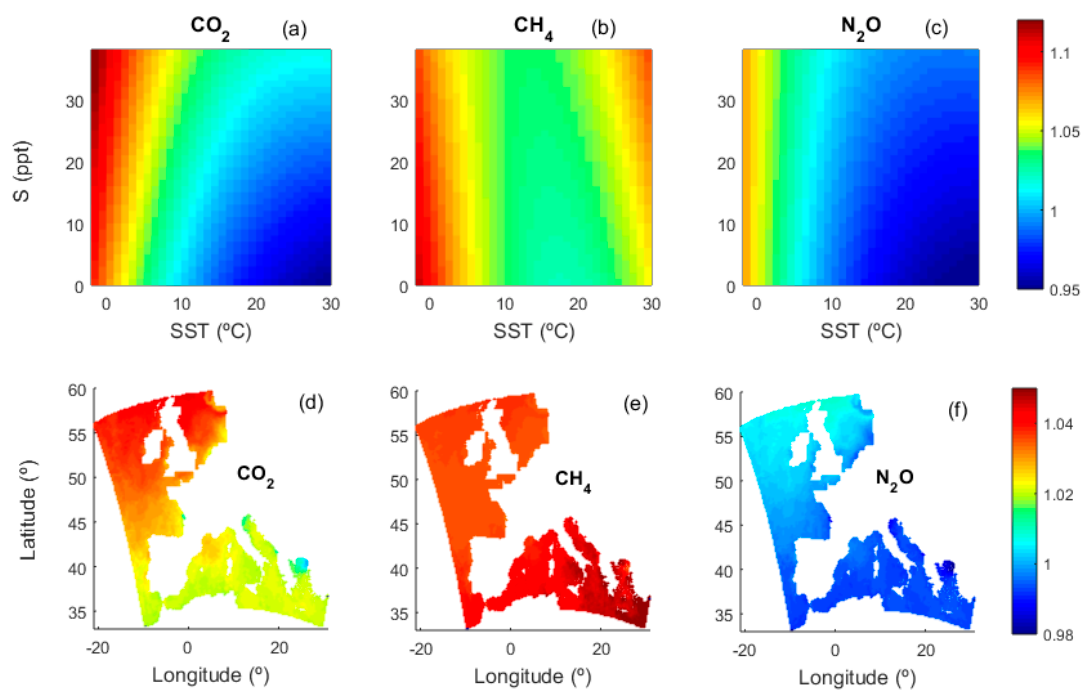
Figure 1. Match–mismatch between estimated solubilities of greenhouse gases. Colour scale is quotient between k H estimated from Johnson [20] and from Sarmiento and Gruber [2]. Solubilities tested for the range of values observable at the Earth’s surface ( a – c ) and at the European coastal ocean from the 24 May 2014 at 06 h to the 27 May 2014 at 00 h ( d – f ) with each pixel corresponding to a square sided 11 km and averaged over the 66 h survey period.